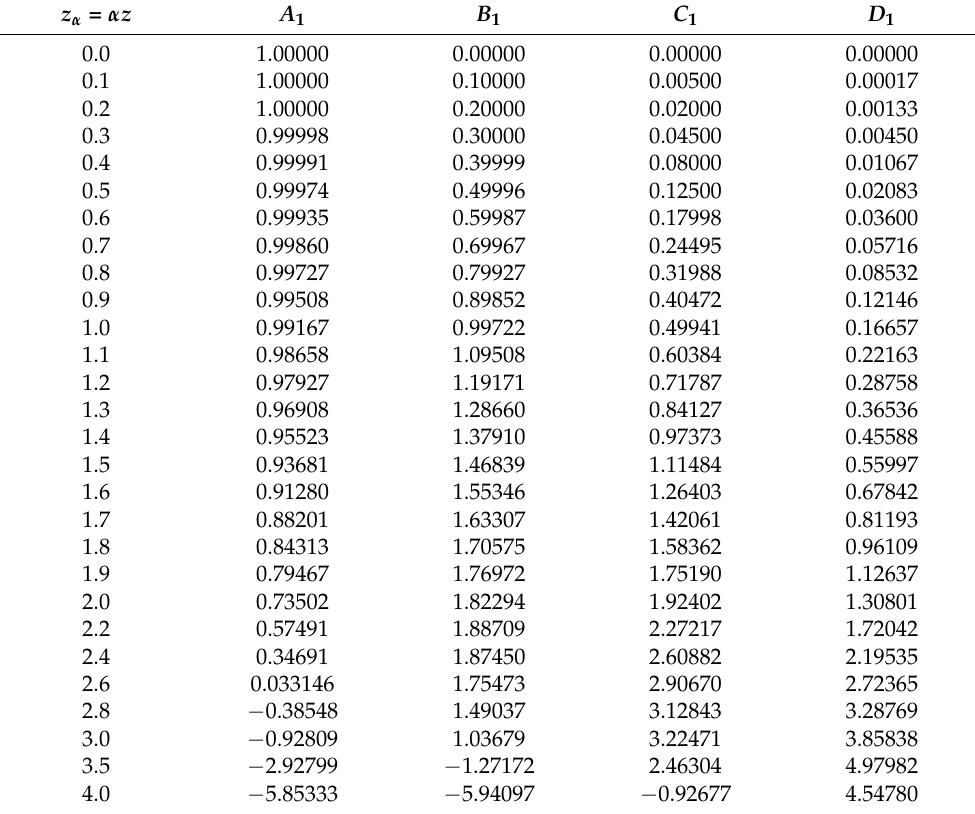
Table A1. Dimensionless coefficient of pile responses ( A 1 , B 1 , C 1 , and D 1 ).